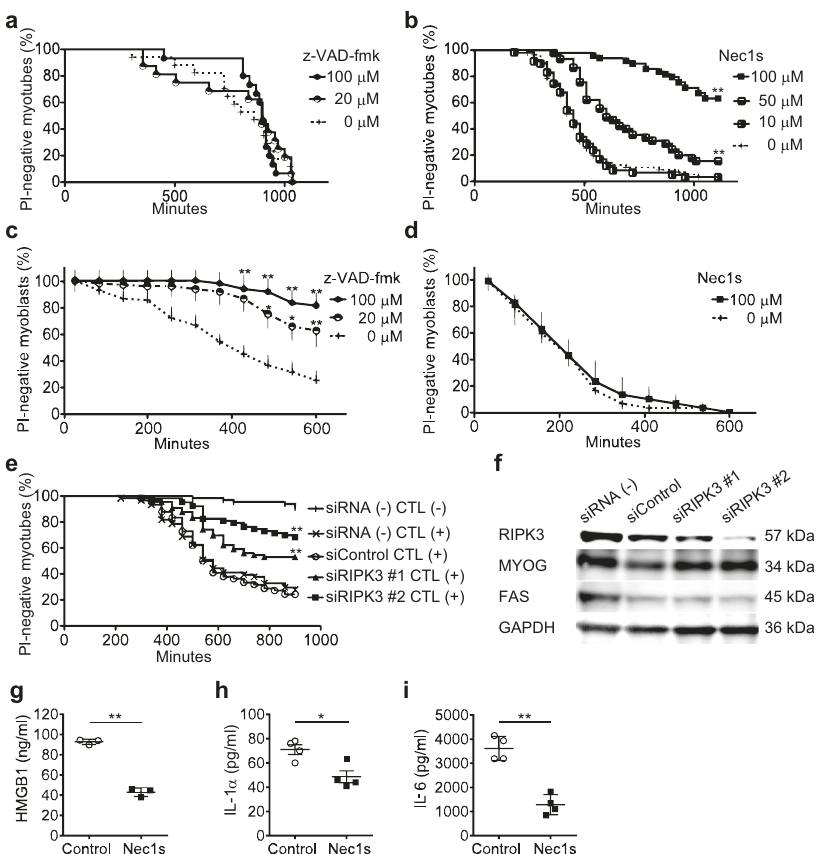
Fig. 4 Effect of apoptosis or necroptosis inhibition on CTL-induced cell death in myotubes and myoblasts. a , b The viability of z-VAD-fmk- or Nec1s- pretreated H2K b OVA-myotubes in the co-culture with OT-I CTLs. z-VAD-fmk 0 μ M: n = 30, 20 μ M: n = 30, 100 μ M: n = 30. Nec1s 0 μ M: n = 56, 10 μ M: n